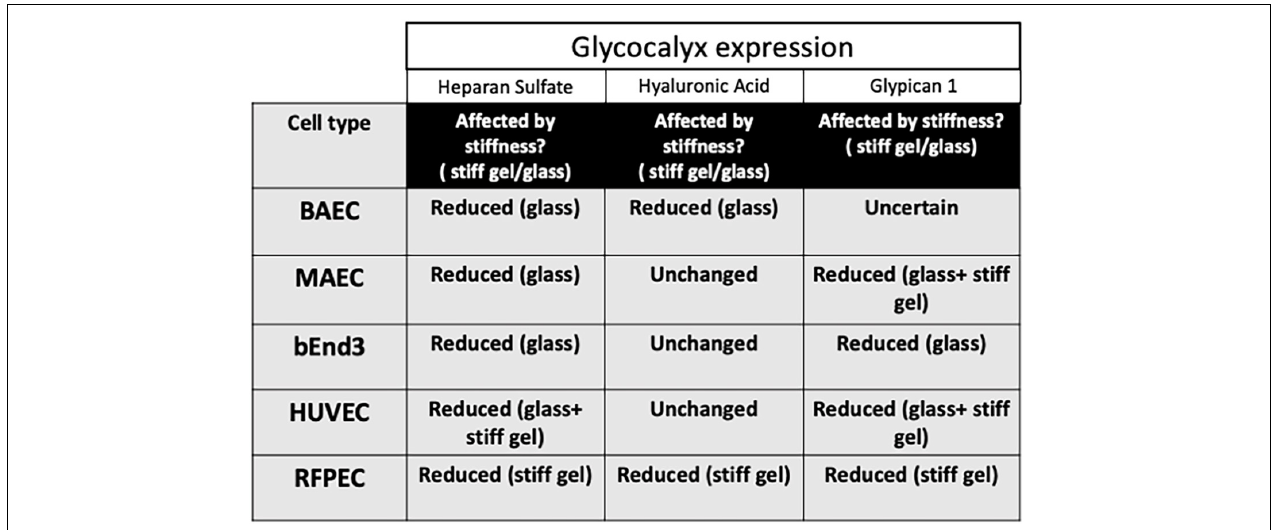
FIGURE 5 | Stiffness inhibits GCX expression in different cell types differently. Summary table to show how matrix stiffness inhibits HS, HA, and Glypican 1 differently for cells cultured on soft, stiff gels or on